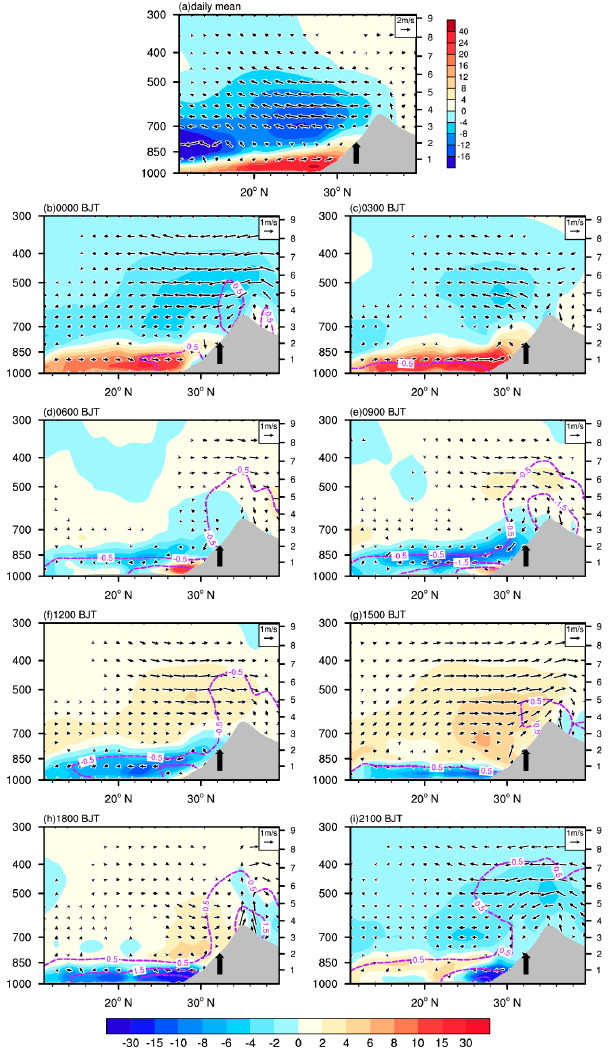
Figure 6. ( a – i ) are the same as in Figure 5a − i, but for the meridional water vapor transport and vertical circulation along 70° − 81° E. The black upward arrows above the topography indicate the western boundary of the TP.